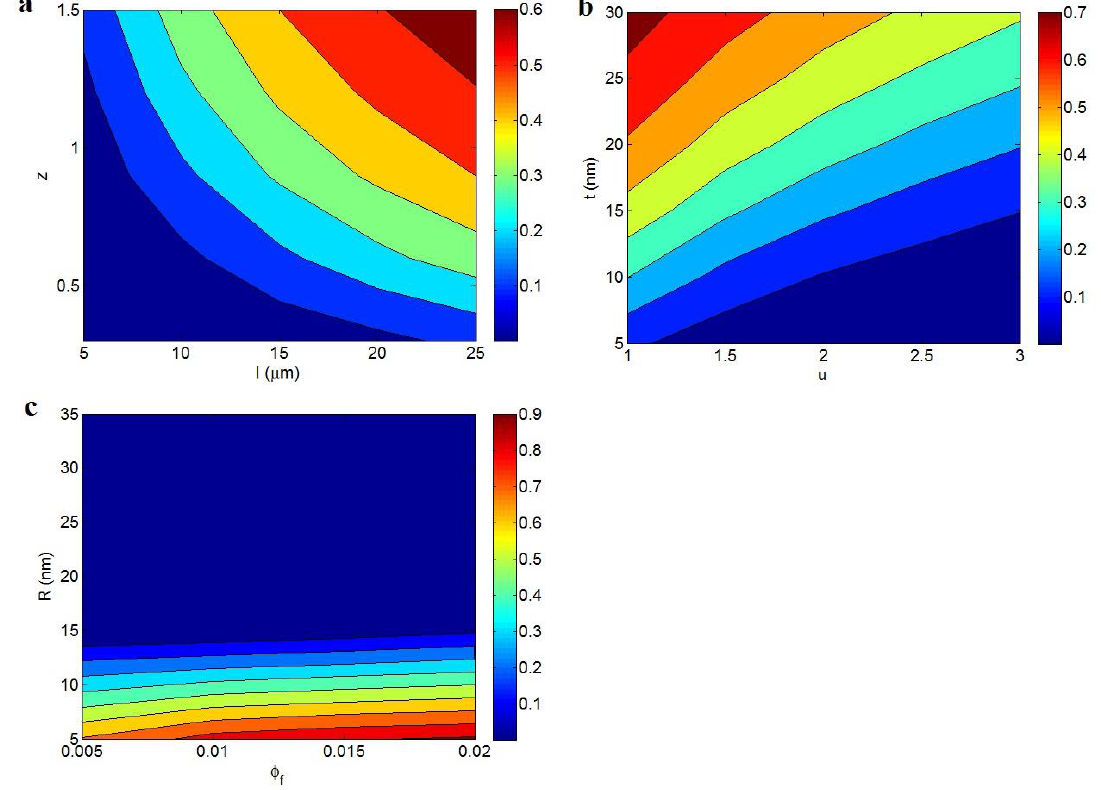
Figure 3. The electrical conductivity of nanocomposites at di ff erent ranges of ( a ) the l and z , ( b ) u and t , and ( c ) ϕ f and R parameters based on Equation